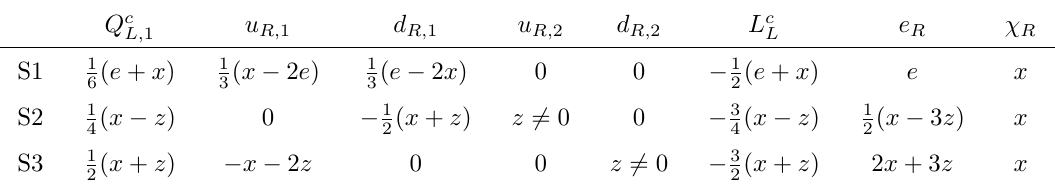
Table 2. Anomaly-free models where only first-generation quarks or one full generation plus either a right-handed second-generation down or up quarks carry U (1) 0 carges. Only the left-handed third- generation lepton doublet carries a U (1) 0 charge to avoid the most stringent bounds from dilepton